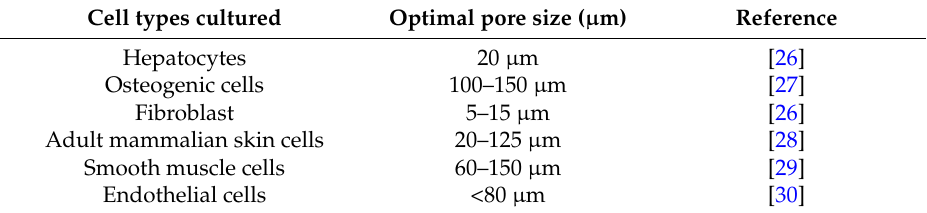
Table 1. Optimal pore size for cell infiltration reported by previous researchers